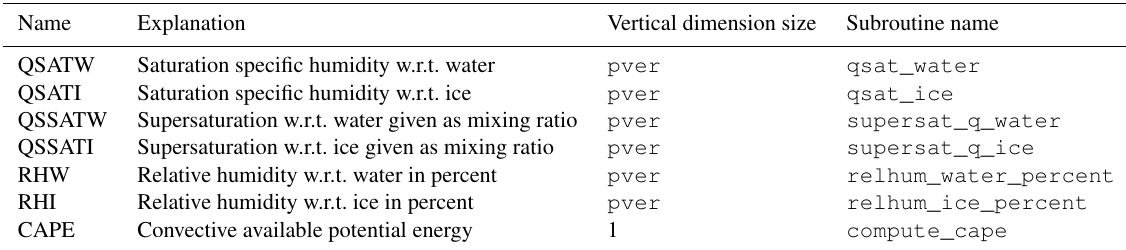
Table A3. Candidate condition metrics and QoIs that are diagnosed from components of EAM’s derived-type data structures. pver and pverp are EAM’s variable names for the number of vertical layers and vertical interfaces, respectively. In the standard v1 model, pver is 72 and pverp is 73. “Subroutine name” is the name of the subroutine in module misc_diagnostics that calculates the requested quantity. More candidates can be added following the the second code snippet in Sect. 4.1.2.